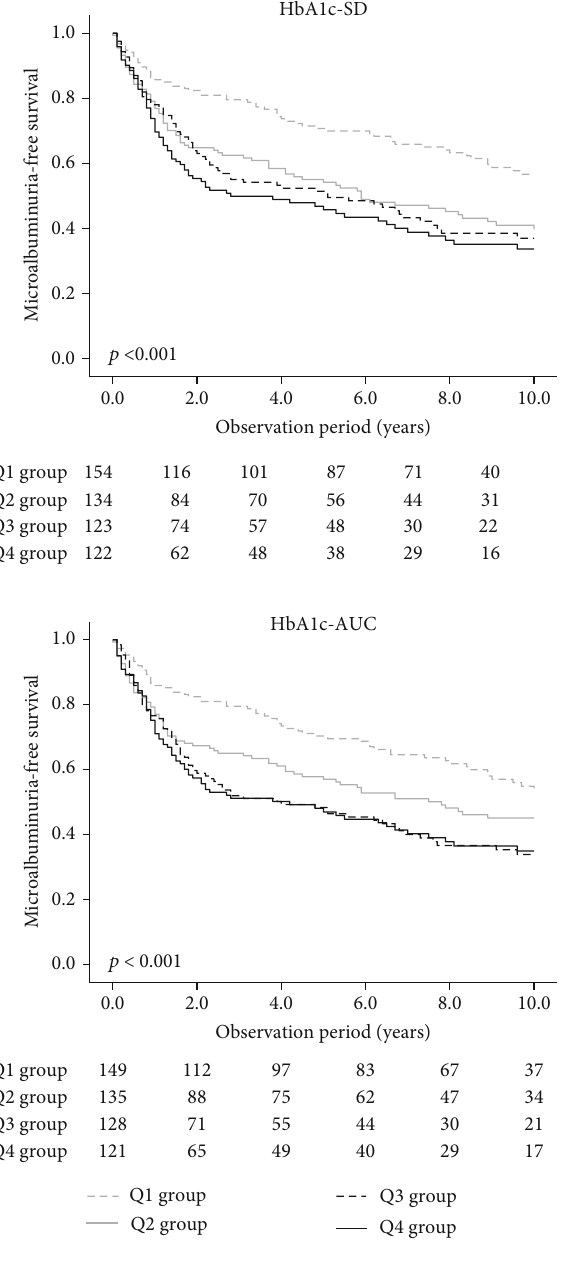
Figure 1: Kaplan-Meier curves for microalbuminuria-free survival among subjects divided by quartiles of the 4 indices of visit-to-visit variability of HbA1c. The quartiles of each index are represented by Q1, Q2, Q3, and Q4. The lower quartile is denoted as Q1, and the upper quartile is denoted as Q4. The comparison of the cumulative incidence among groups was carried out using a log rank test. HbA1c-SD: internal standard deviation of HbA1c; HbA1c-CV: coe ffi cient of variation of HbA1c; HbA1c-AUC: area under the